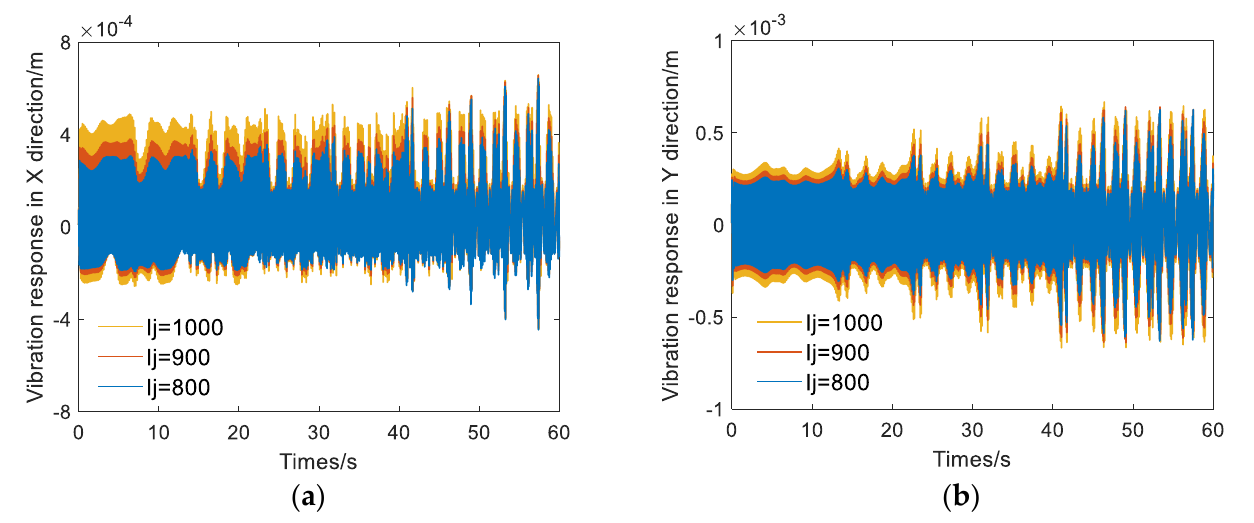
Figure 12. Shafting vibration response in the X and Y directions of the unit with different I j ; ( a ) shafting vibration response in X direction; ( b ) shafting vibration response in Y direction.